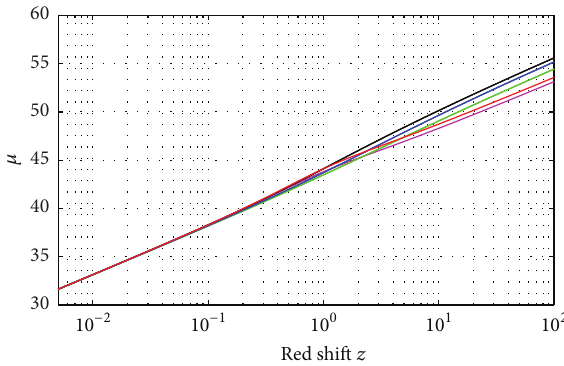
Figure 3: As in Figures 1 and 2, but model results extended to red shift 𝑧 = 100 . If at all it is possible to extend observational data to even a red shift 𝑧 ∼ 5 , that would provide strong evidence to validate or reject the proposed